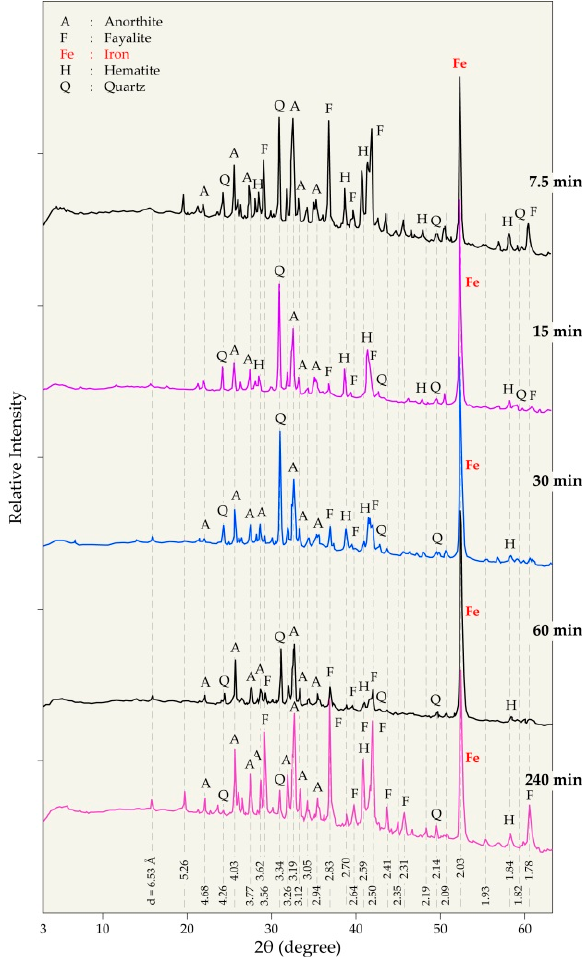
Figure 12. XRD diffractograms of the residues obtained during the treatment of (hematite + W-PVC + clay) the mixture at 1025 °C for different reaction times.